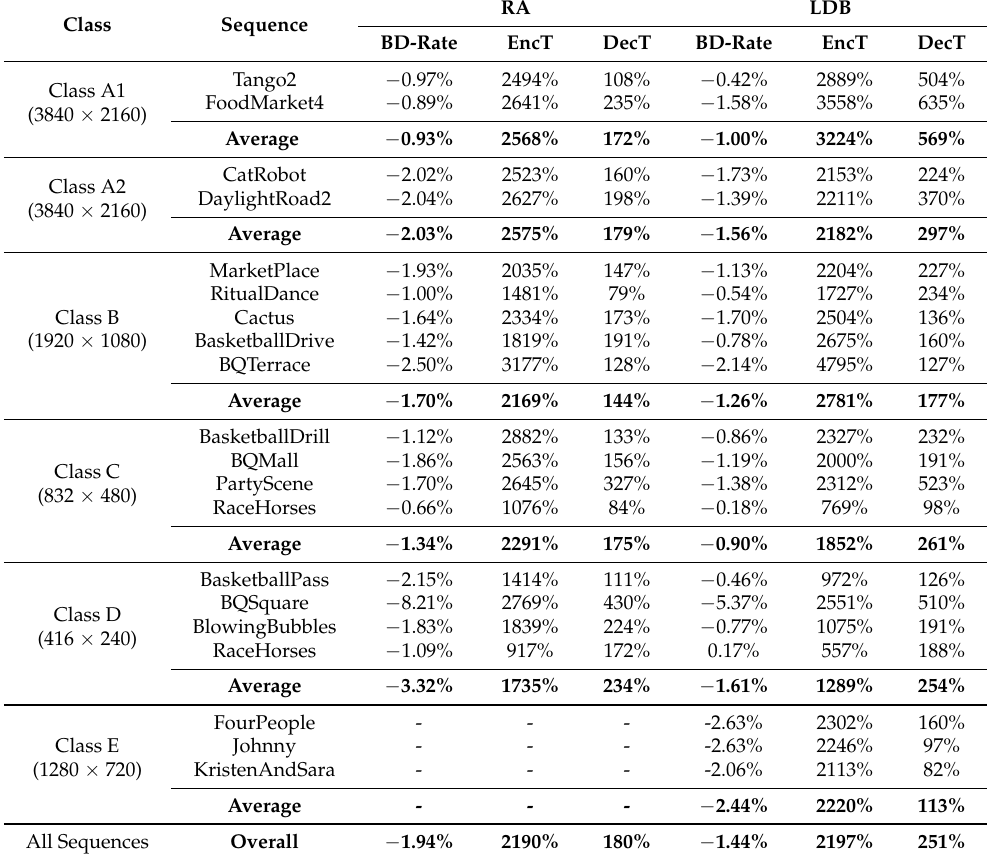
Table 4. BD-rate reduction and encoding/decoding computational complexity compared to VTM-11.0 NNVC-1.0